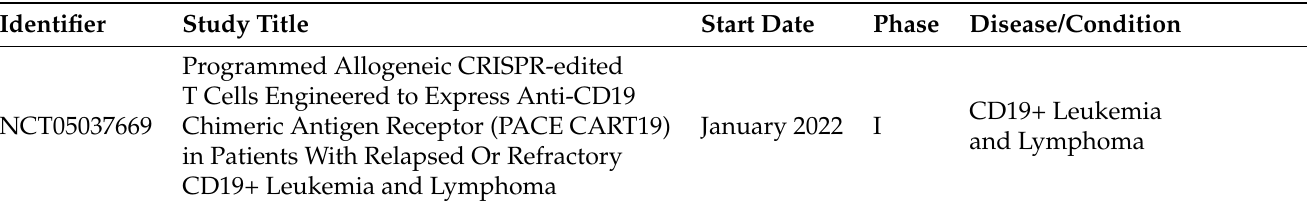
created with BioRender.com (accessed on 23 November 2021)). Table 3. Examples of currently ongoing clinical trials, using CRISPR/Cas9 system for the